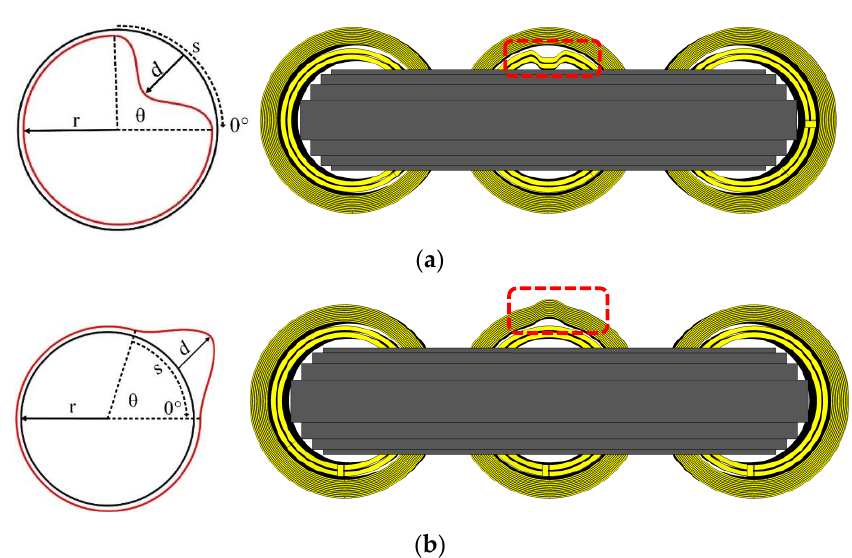
Figure 17. Representation of the radial deformation fault (RDF); schematic ( left ); 3D HF model ( right ); ( a ) compression failure in LV winding; ( b ) hoop tension failure in HV winding.